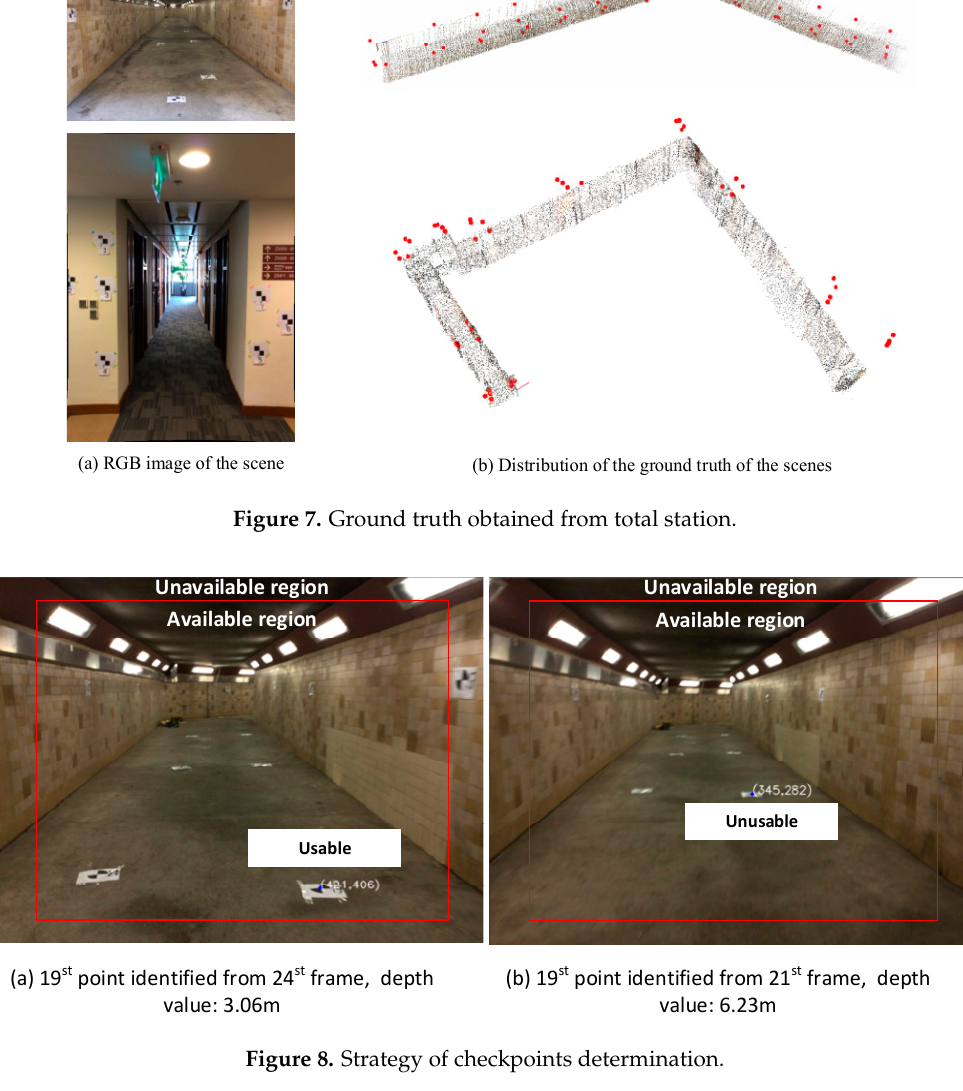
Figure 8. Strategy of checkpoints determination.